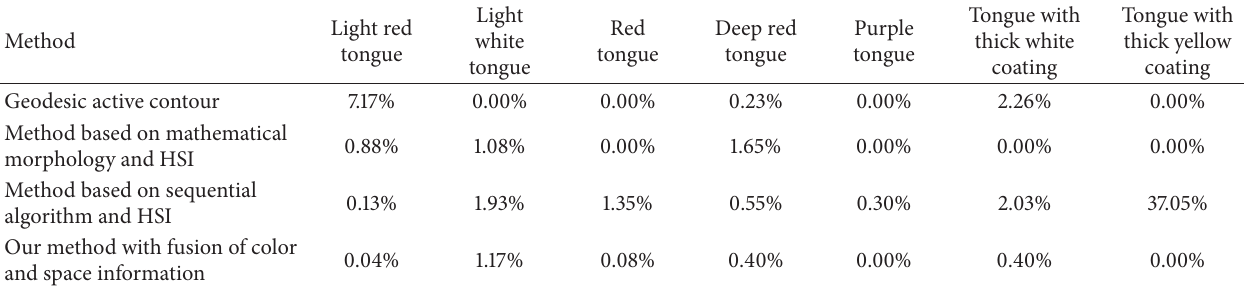
Table 2: Error rates of 4 kinds of tongue image extraction methods.